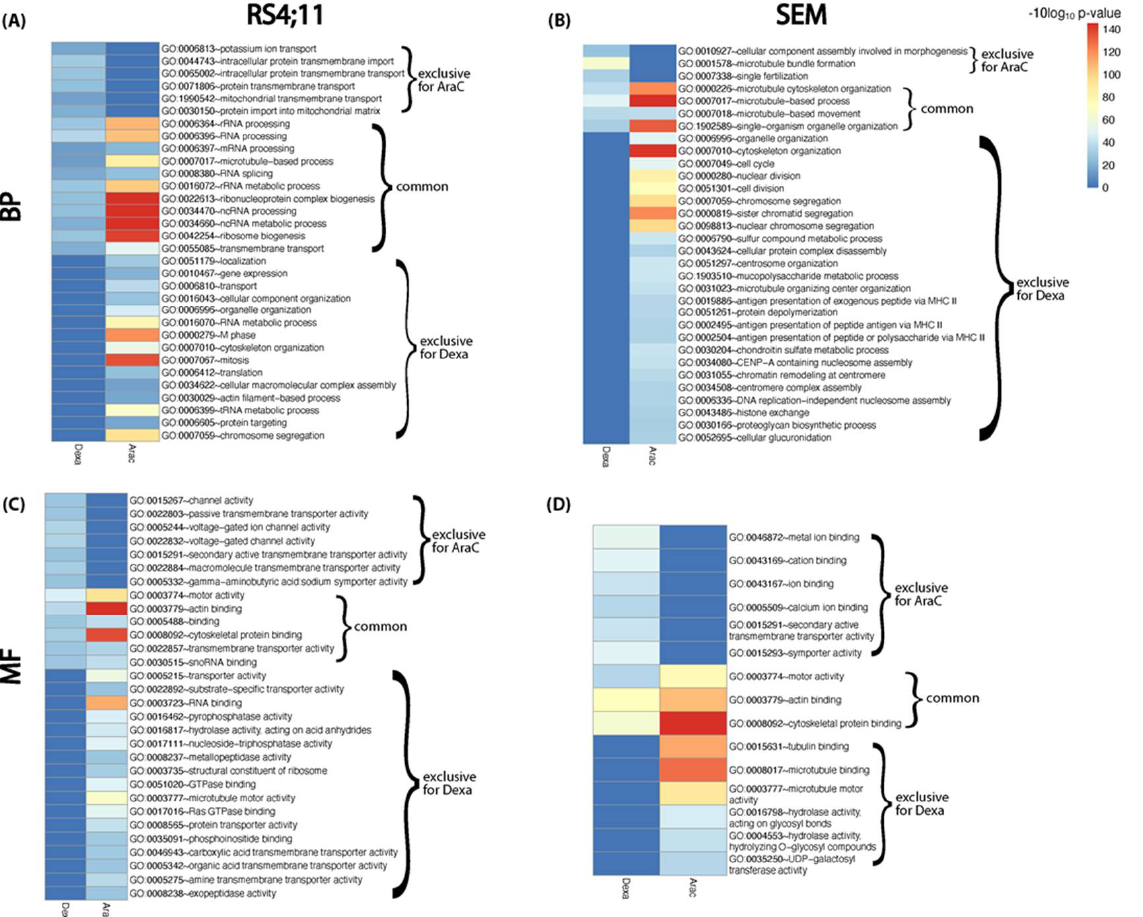
Figure 4. Over-represented biological processes and molecular functions for the cell lines RS4;11 ( A ) and for SEM ( B ) shown separately for the exclusive patterns for the drug releases of AraC and Dexa, as well as the common ones. The molecular functions for RS4;11 ( C ) and SEM ( D ) in response to the drug release of AraC and Dexa differentiating between common and exclusive over-representation.